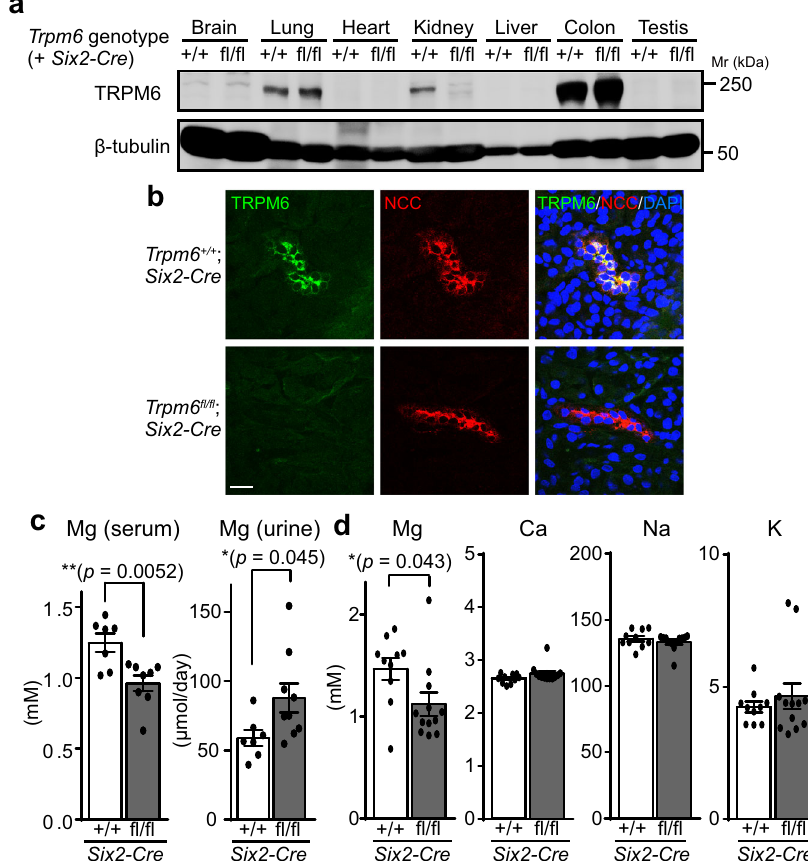
Fig. 1 Disrupted magnesium homeostasis in Trpm6 -de fi cient mice. a Lysates obtained from various organs of 2-month-old Trpm6 + / + ; Six2-Cre and Trpm6 fl / fl ; Six2-Cre mice were subjected to immunoblotting with an anti-TRPM6 antibody. A representative result from two independent experiments with similar results are shown. b Cryosections of 2-month-old Trpm6 + / + ; Six2-Cre and Trpm6 fl / fl ; Six2-Cre mice were subjected to immuno fl uorescence staining with an anti-TRPM6 antibody (green), an anti-NCC antibody (red), and DAPI (blue). Bar, 20 μ m. A representative result from three independent experiments with similar results are shown. c Colorimetric quantitation of magnesium (Mg) in serum and urine samples obtained from 2- to 3-month-old mice of Trpm6 + / + ; Six2-Cre and Trpm6 fl / fl ; Six2-Cre mice. Data are shown as means ± SEM (from left to right, n = 7, 8, 7, 9 mice). The p -values were determined by Student ’ s two-tailed t -tests (unpaired). * p < 0.05, ** p < 0.01. d Serum samples were subjected to elemental analyses using ICP-ES. Data are shown as means ± SEM ( n = 10 for Trpm6 + / + ; Six2-Cre mice and n = 12 for Trpm6 fl / fl ; Six2-Cre mice). The p -values were determined by Student ’ s two-tailed t -tests (unpaired). * p <